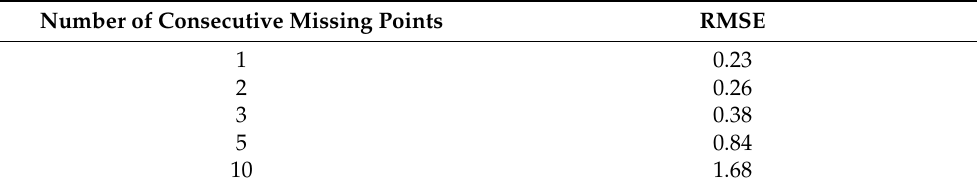
Table 2. Root mean square error (RMSE) of original data and added data under different numbers of consecutive missing points.